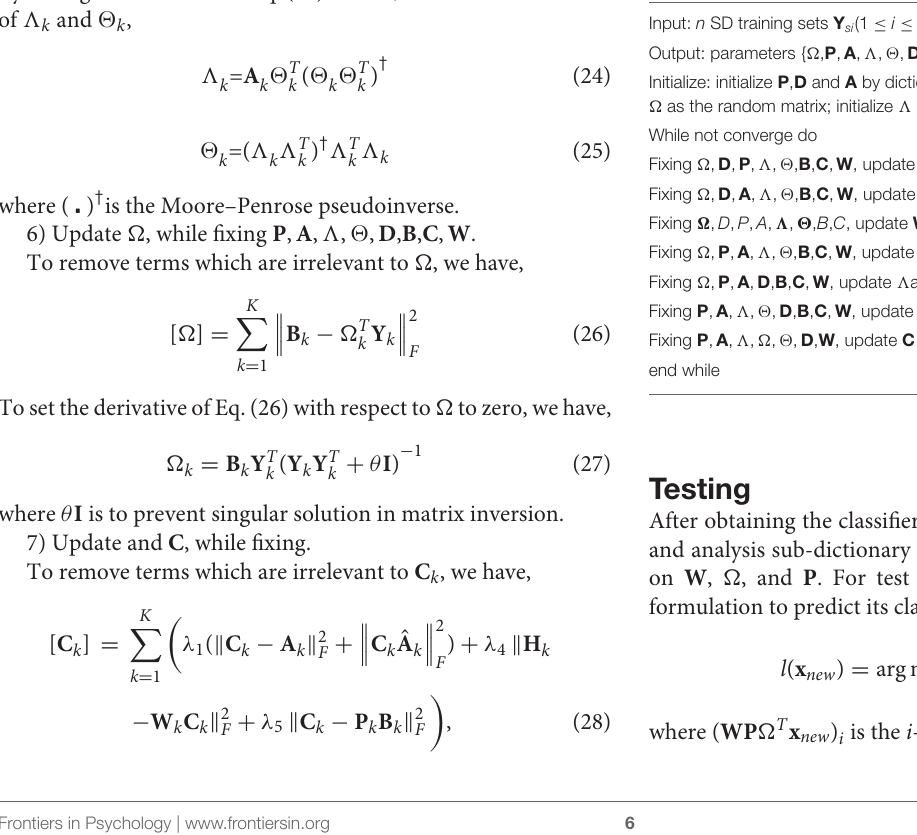
Algorithm 1 | Transfer discriminative dictionary pair learning